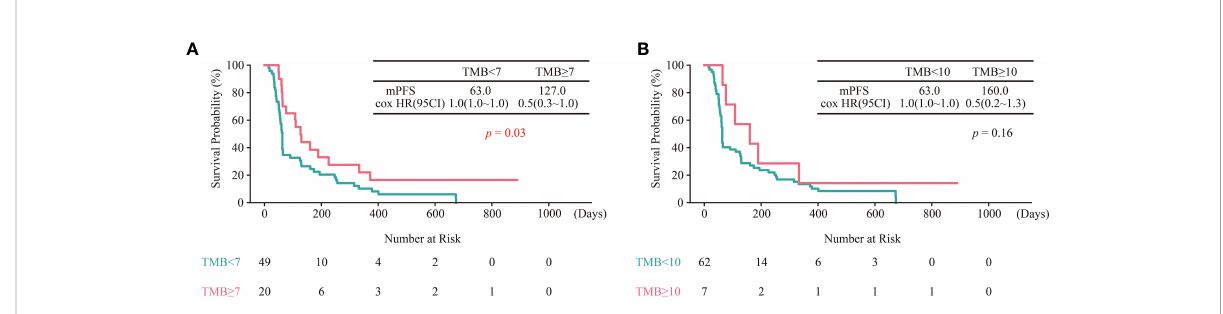
FIGURE 5 Validation of TMB cut-off of 7 mut/Mb in the test cohort. (A) Kaplan – Meier curves of OS comparing TMB ≥ 7 group and TMB< 7 group. (B) Kaplan – Meier curves of OS comparing TMB ≥ 10 group and TMB< 10